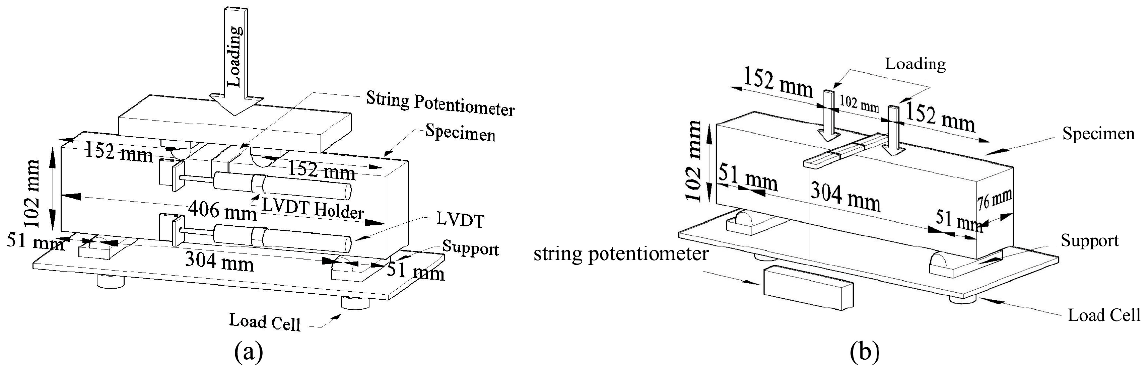
Figure 2. Schematic of fl exural test: ( a ) front view and ( b ) back view.